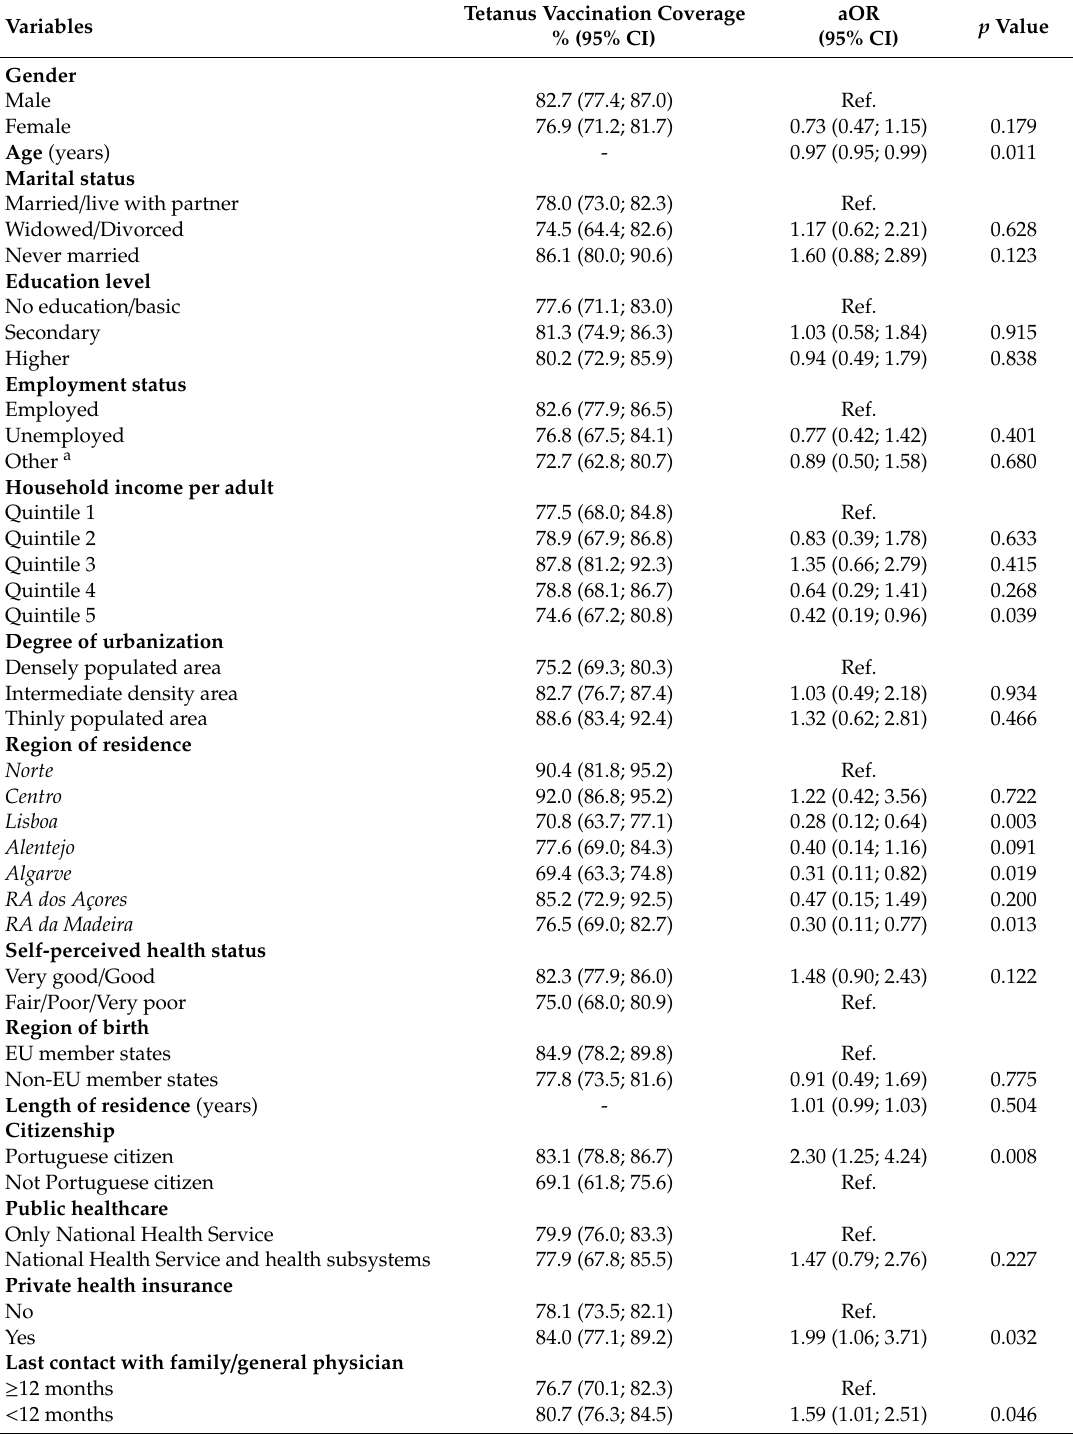
Table 2. Determinants of self-reported tetanus vaccination coverage among adult immigrants ( ≥ 18 years of age) living in Portugal, National Health Survey 2014 §